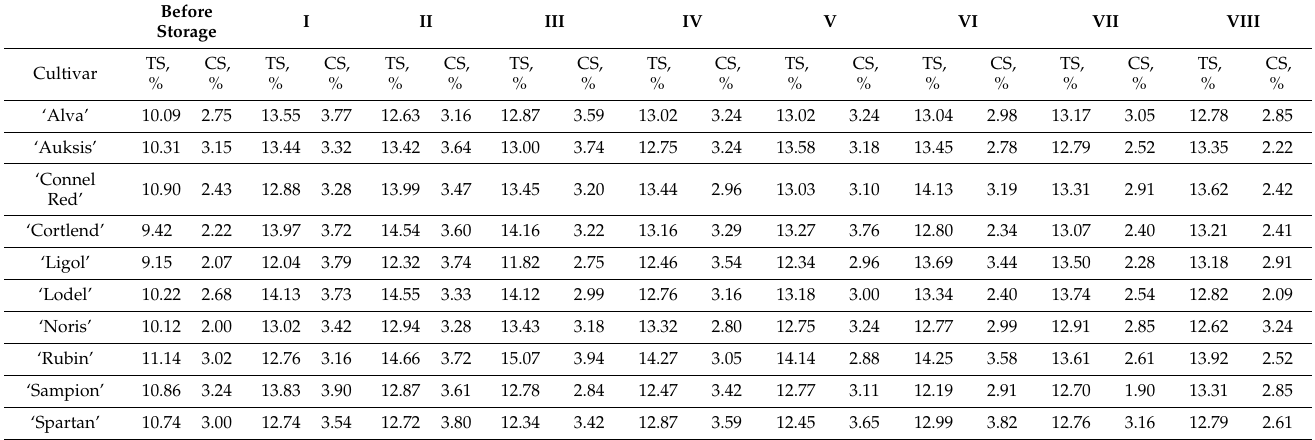
Table 2. Variability of the total sugar and sucrose content in apple samples before and after storage in CA. Before